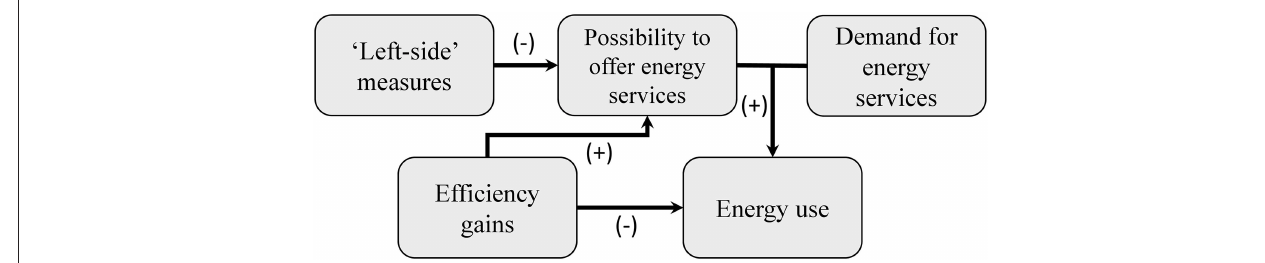
FIGURE 5 | The role of ‘left-side’ measures in preventing consumption increase.